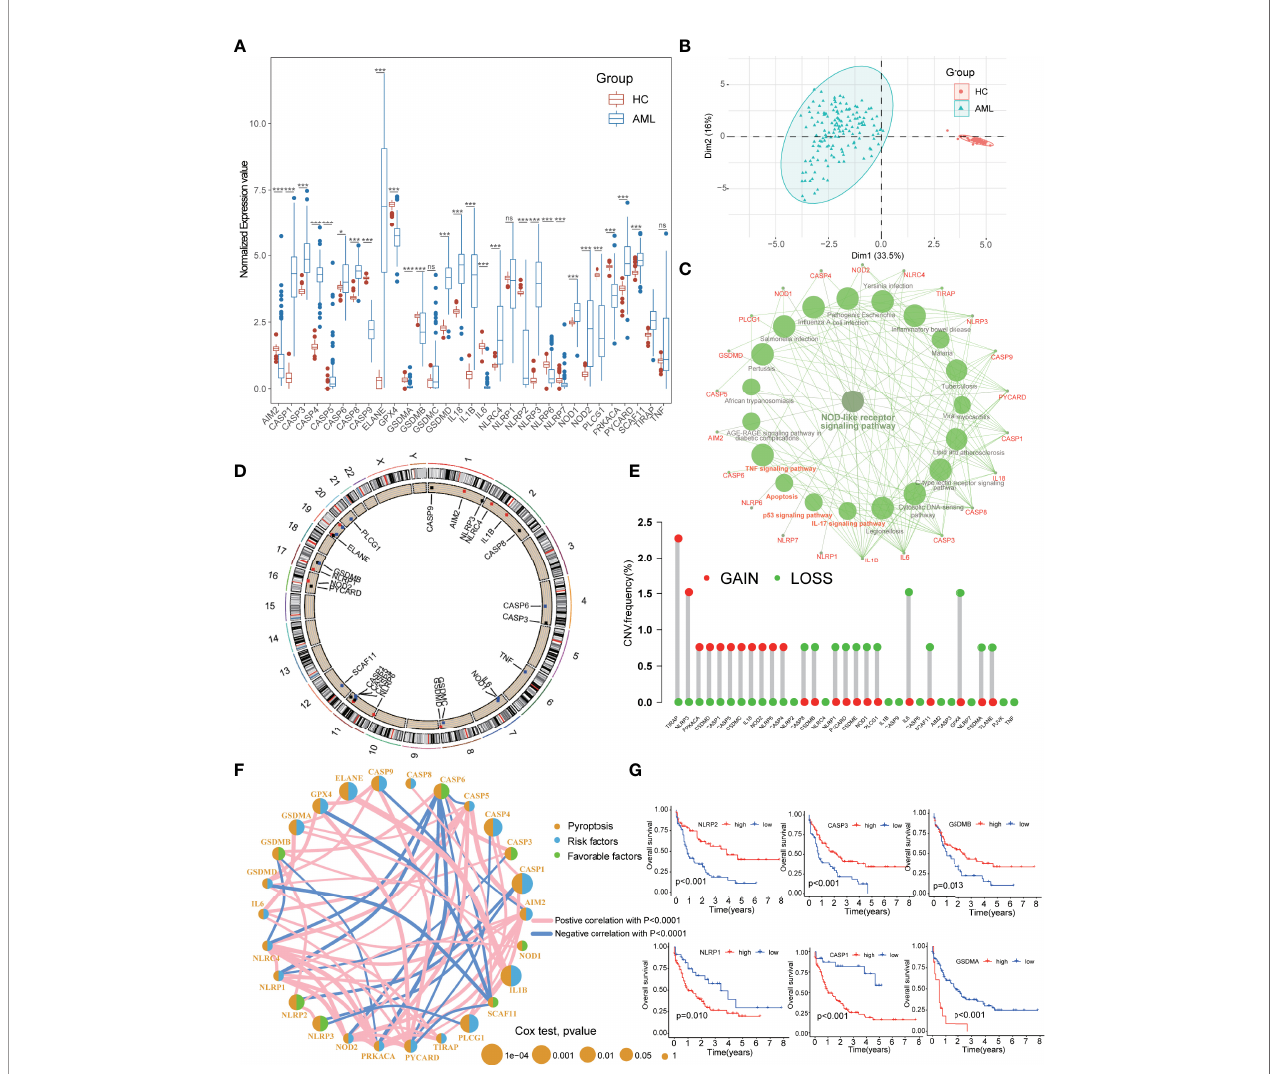
FIGURE 2 | Expressional and mutational characteristics of PRGs in AML. (A) Expression of 33 PRGs between AML and the healthy control (HC). (B) PCA showing that the HC and the AML were signi fi cantly divided into two groups. (C) The KEGG pathway enrichment analysis of the PRGs. (D, E) The situation of CNV gain and loss of the PRGs on 23 chromosomes. (F) Prognostic characteristics and expressional relation among PRGs in AML . (G) PRGs with the same families but different outcomes for prognosis of the AML. AML, acute myeloid leukemia; PRGs, pyroptosis-related genes; PCA, principal component analysis; CNV, Copy number variants. *P<0.05, **P<0.01, ***P<0.001; ns, not signi fi